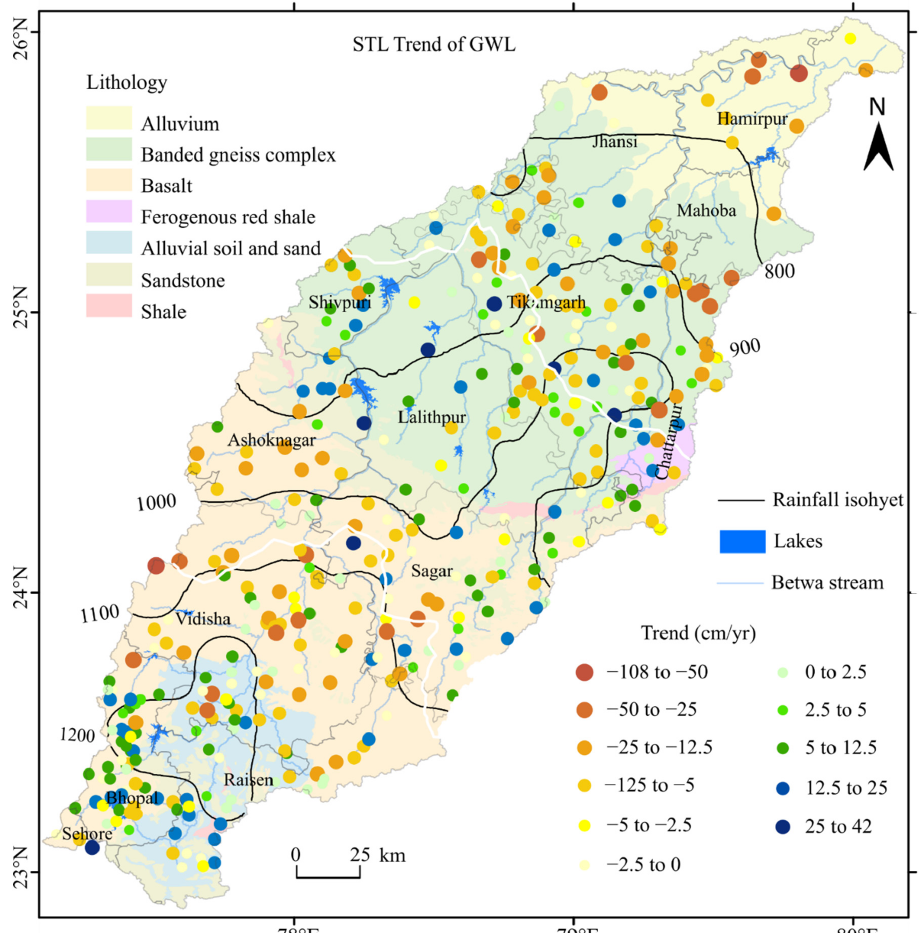
Figure 9. Spatial distribution of the GWL trend component obtained from the STL decomposed. The lithology map is used in the background to understand the variability of the GWL trend in different lithology and geology types. Isohyetal lines in black illustrate the spatial distribution of mean annual rainfall in the study area.